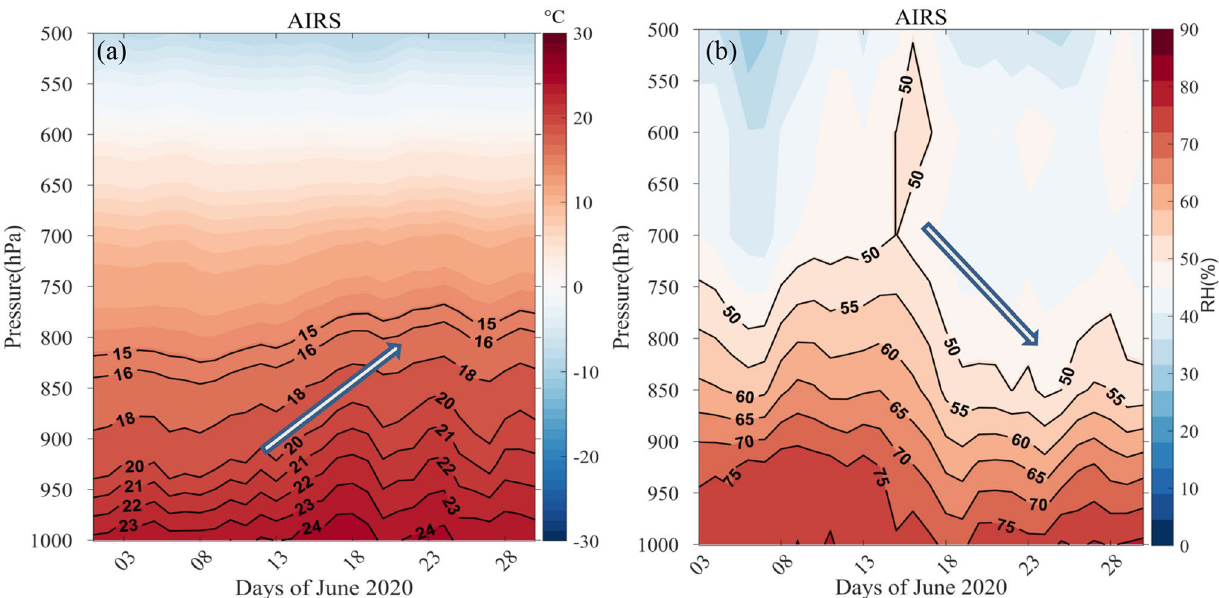
Figure 7. Area averaged time-height plot of ( a ) Temperature and ( b ) Relative humidity using AIRS during the dust storm. The map was generated using MATLAB 2015b, www. mathw orks.